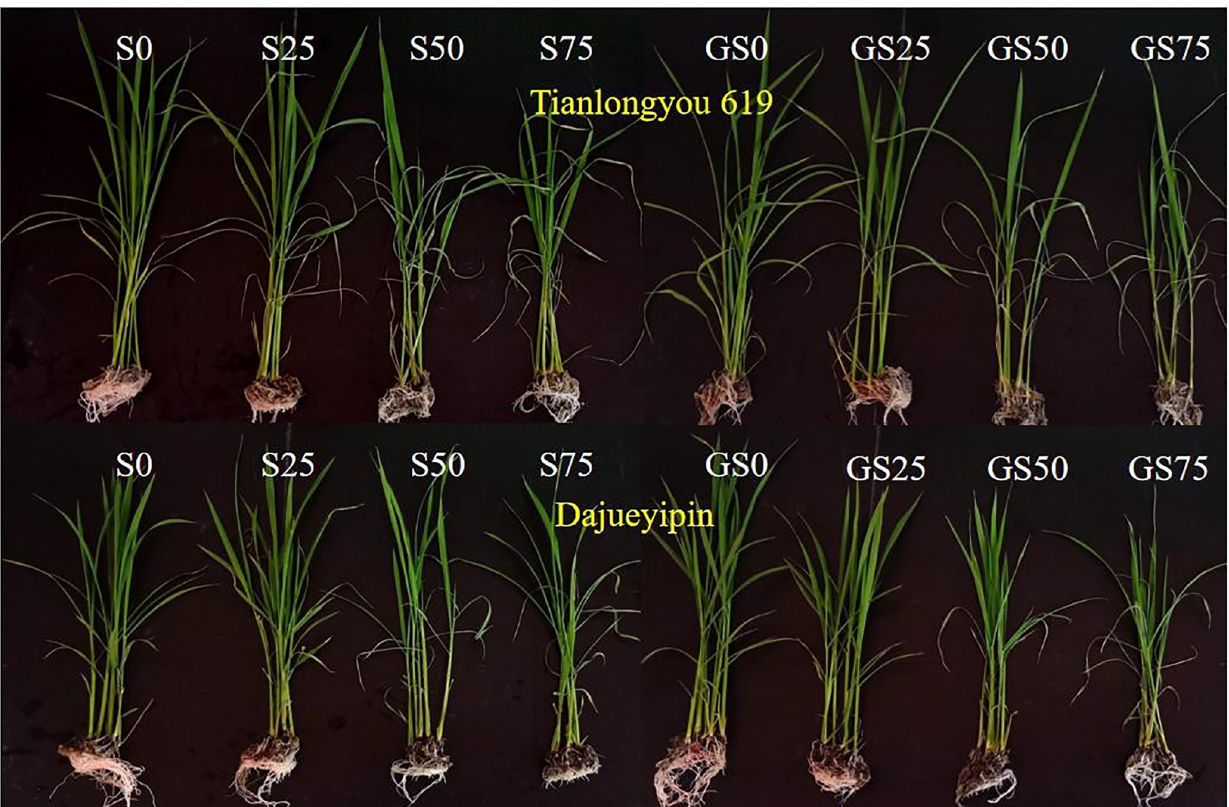
Fig 1. Rice seedling growth under different salt or/and GABA treatments at the end of the experiment.